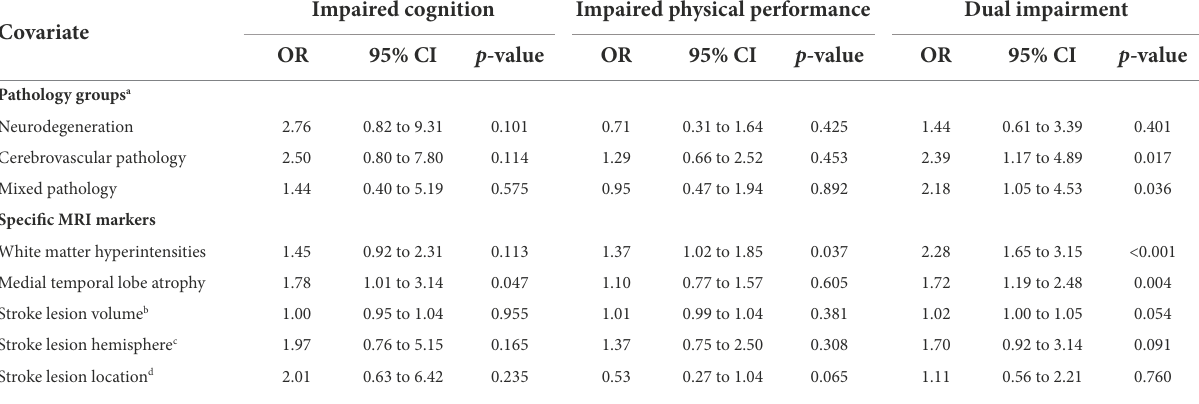
TABLE 3 Multinominal logistic regression, unadjusted.